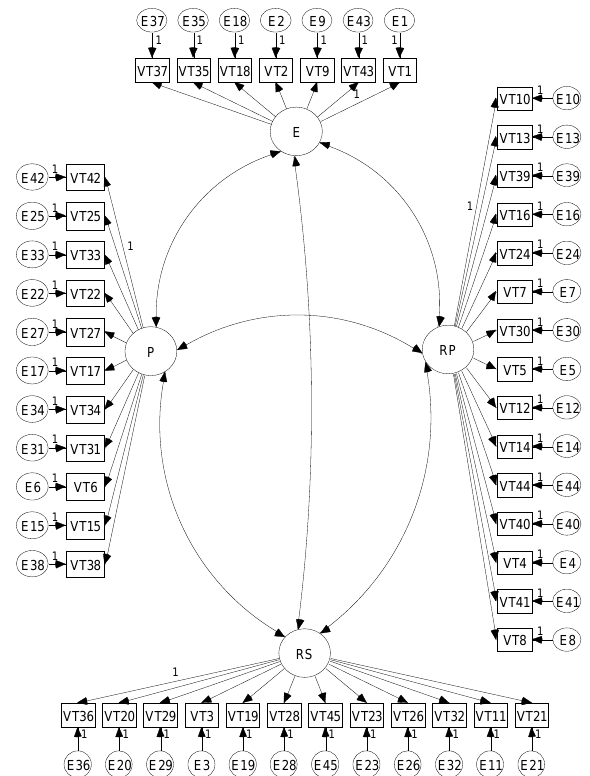
Figura 1 . Modelo estrutural da AFC da Escala EVT de Porto e Tamayo